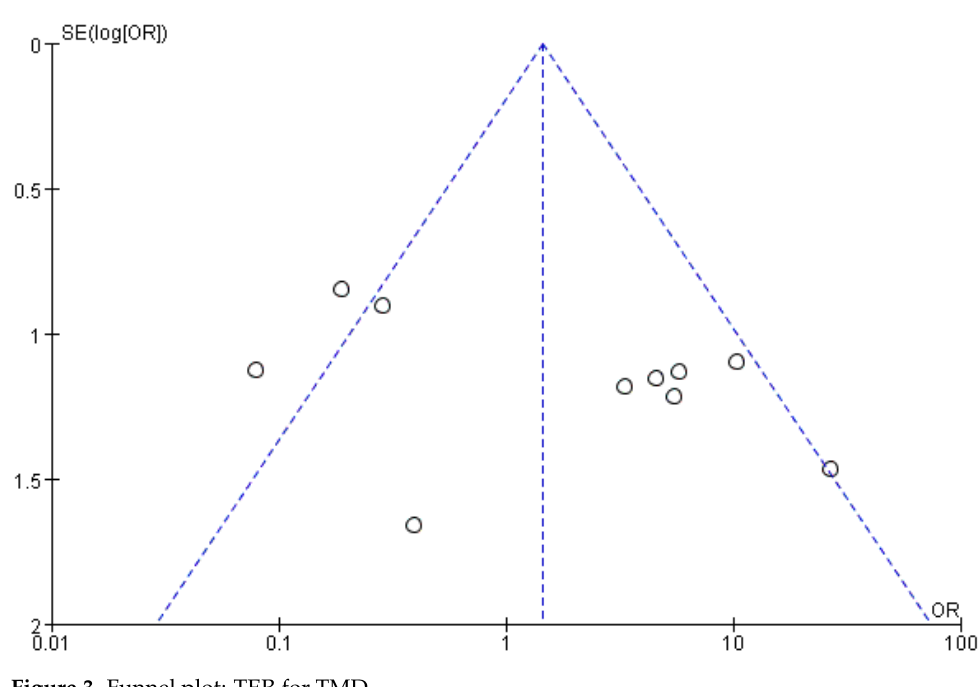
Figure 3. Funnel plot: TER for